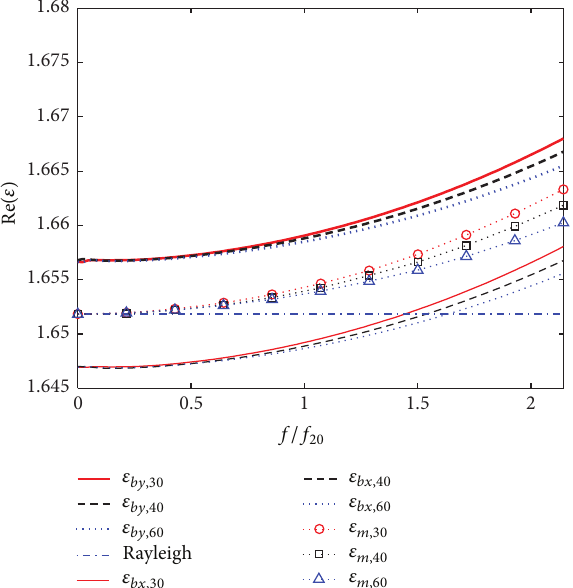
Figure 13: Retrieved angle dependent 𝜀 𝑏𝑥 and 𝜀 𝑏𝑦 of the boundary layerfordifferent 𝜃 0 .Theinnerlayer 𝜀 𝑚 isfixedandequals 𝜀 𝑚 (𝜃 0 = 0) of IBL-model. The subscript numerals denote the incidence angles.